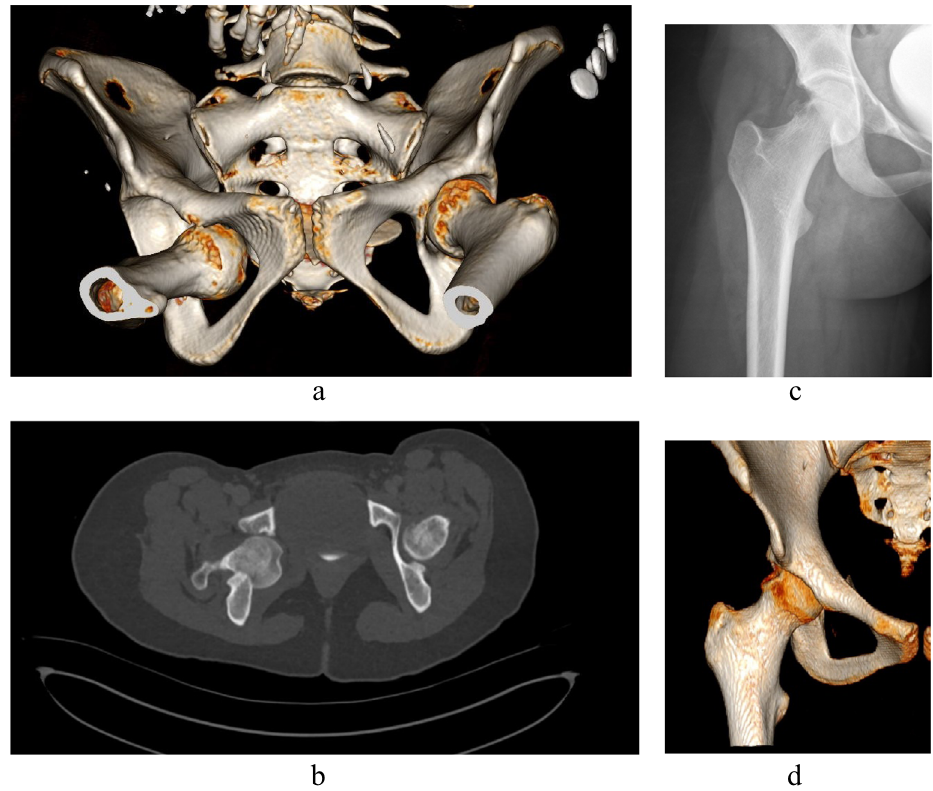
Figure 1. Right hip obturator dislocation before (a, b) and after closed reduction (c,